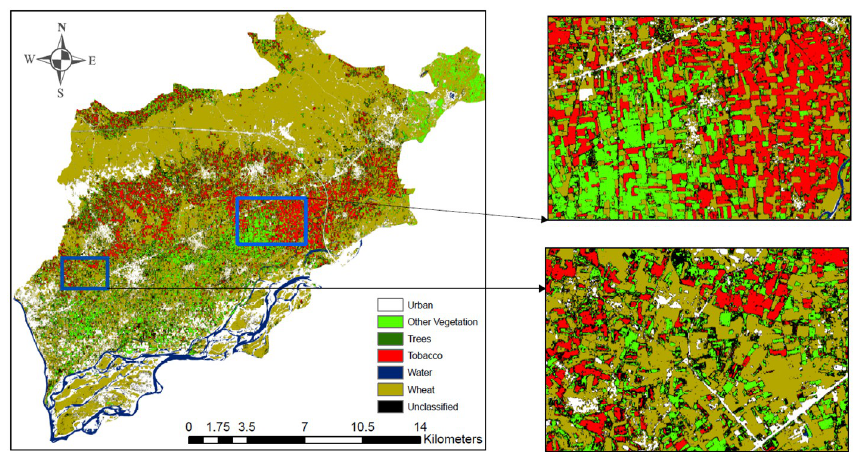
Fig 10. ConvLSTM classified map (generated through our own model and no copyright permission is required) of the region of